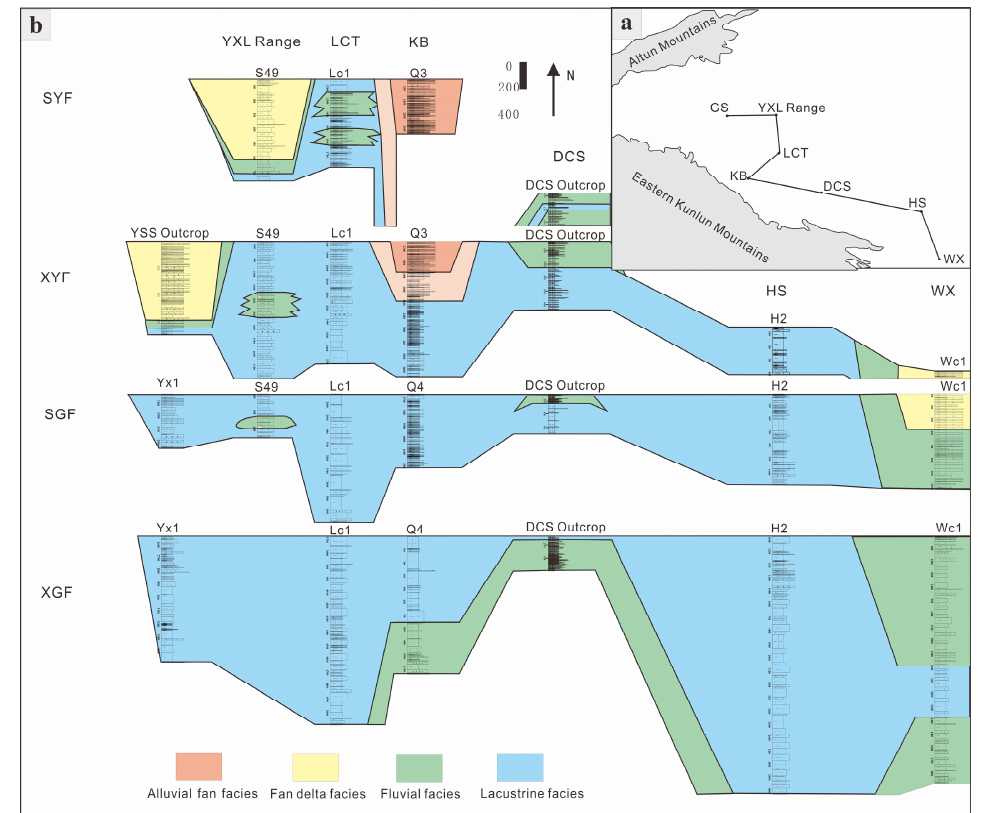
Figure 4. ( a ) The tectonic location of selected wells in southwestern Qaidam Basin; ( b ) the sedimen- tary profile of southwestern Qaidam Basin. Note that the well locations in the profile are shown in Figure 1b.